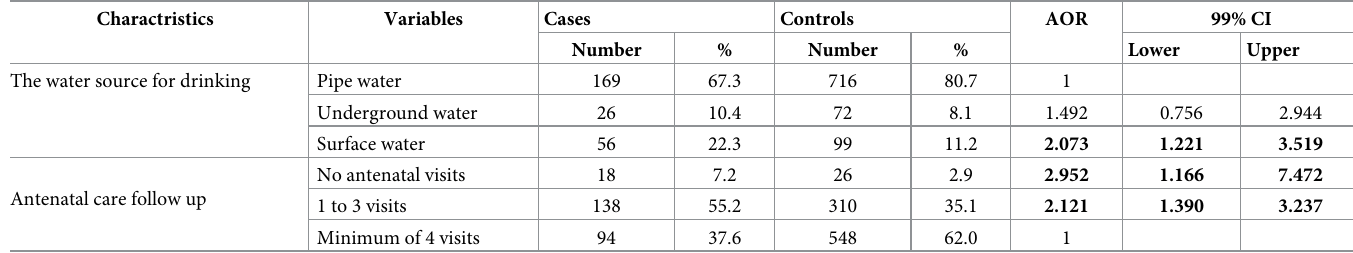
Table 7. Responses of study subjects on possible risk factors for CAs: Multivariable analysis of AOR for associated risk factors of CAs in southwestern Ethiopia. Charactristics